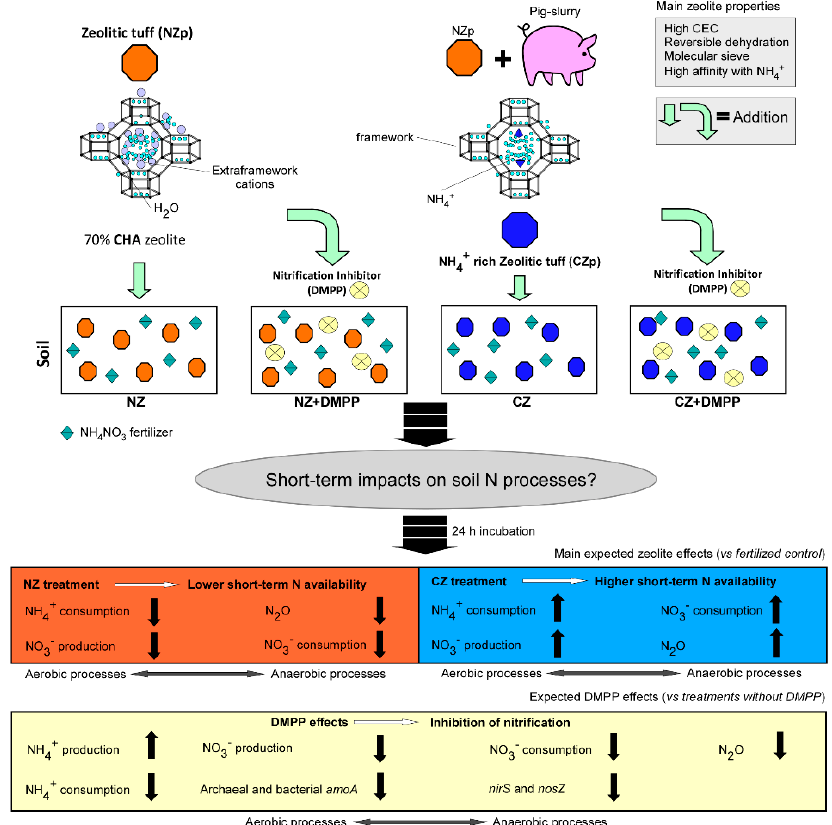
Figure 1. Conceptual scheme of the experiment, including the main expected results for each treat- ment. Representation of framework structure and location of water molecules and extra-framework cations of the chabazite zeolite were taken and adapted from [26].